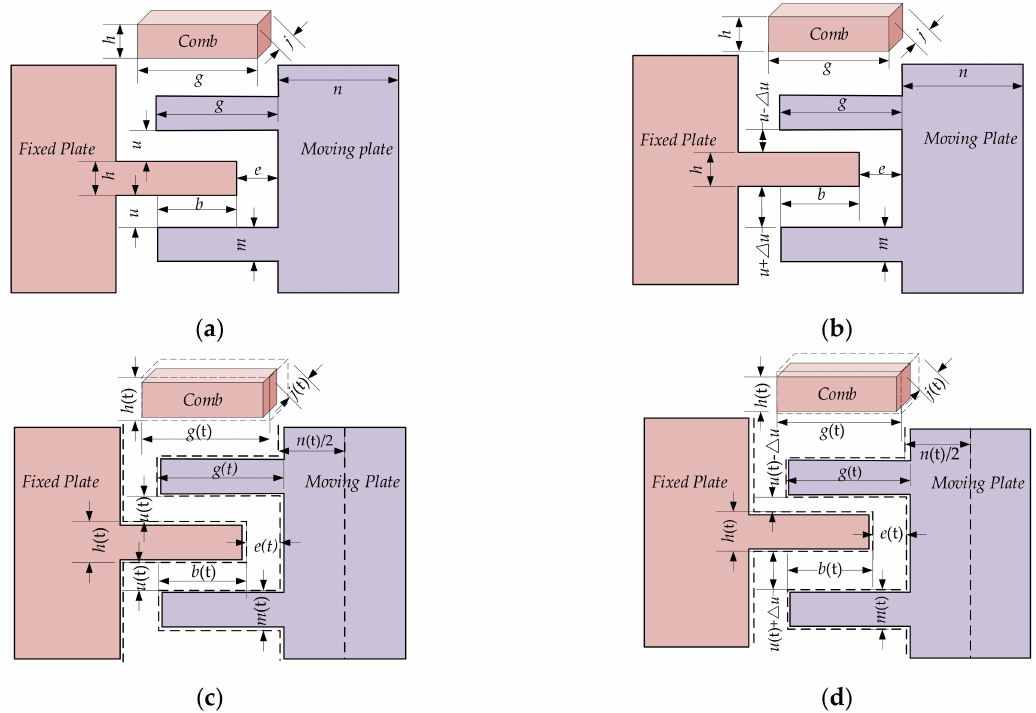
Figure 4. Structural deformation of MEMS accelerometer in diverse conditions. ( a ) Local structure under static state without TEP. ( b ) Local structure under working state without TEP. ( c ) Local structure under static state with TEP. ( d ) Local structure under working state with